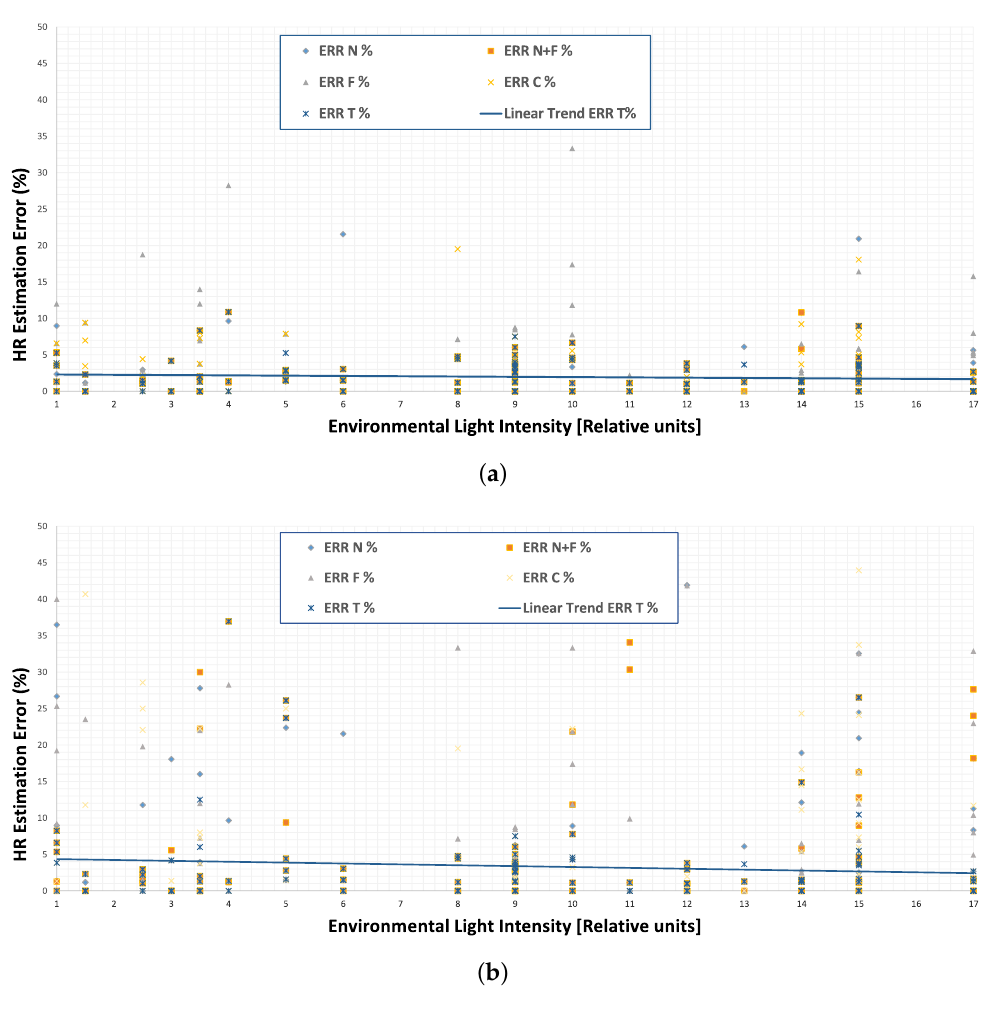
Figure 6. Average error (%) in HR estimation for the system based on RGB data with different light conditions on different ROIs; ( a ) supervised approach; ( b ) unsupervised approach. Table 4. RMSE and R-squared